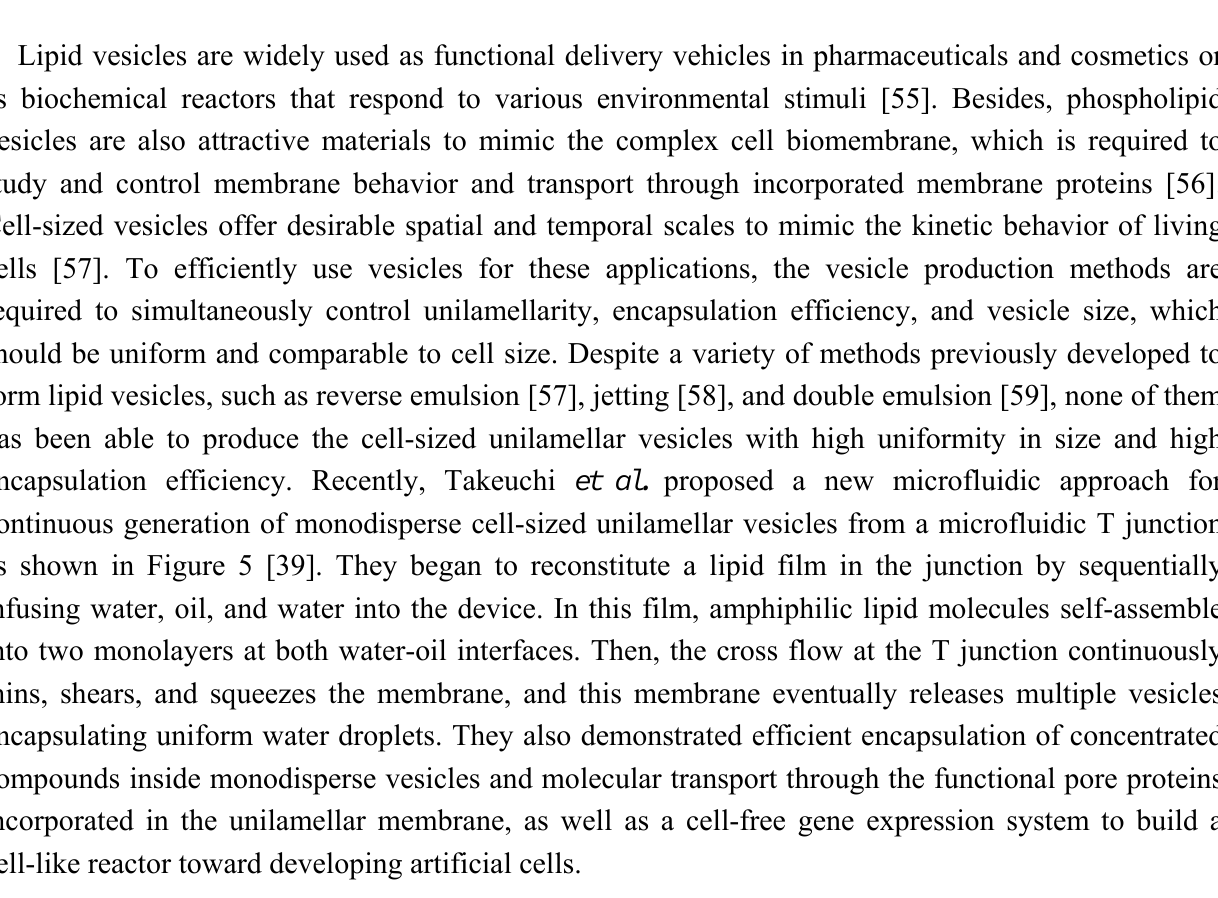
Figure 5. A microfluidic technique using a continuous fluid stream to generate monodisperse unilamellar phospholipid vesicles from a single bilayer (Reproduced with permission from [39]. Copyright 2009 Wiley-VCH Verlag GmbH & Co.